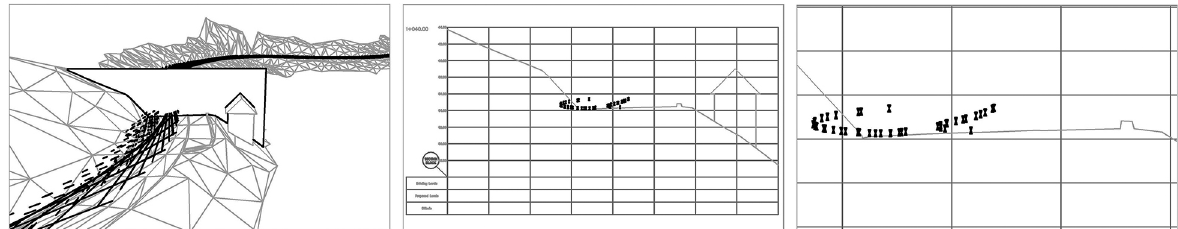
Fig. 8. Transferring lines of sight penetration points into cross